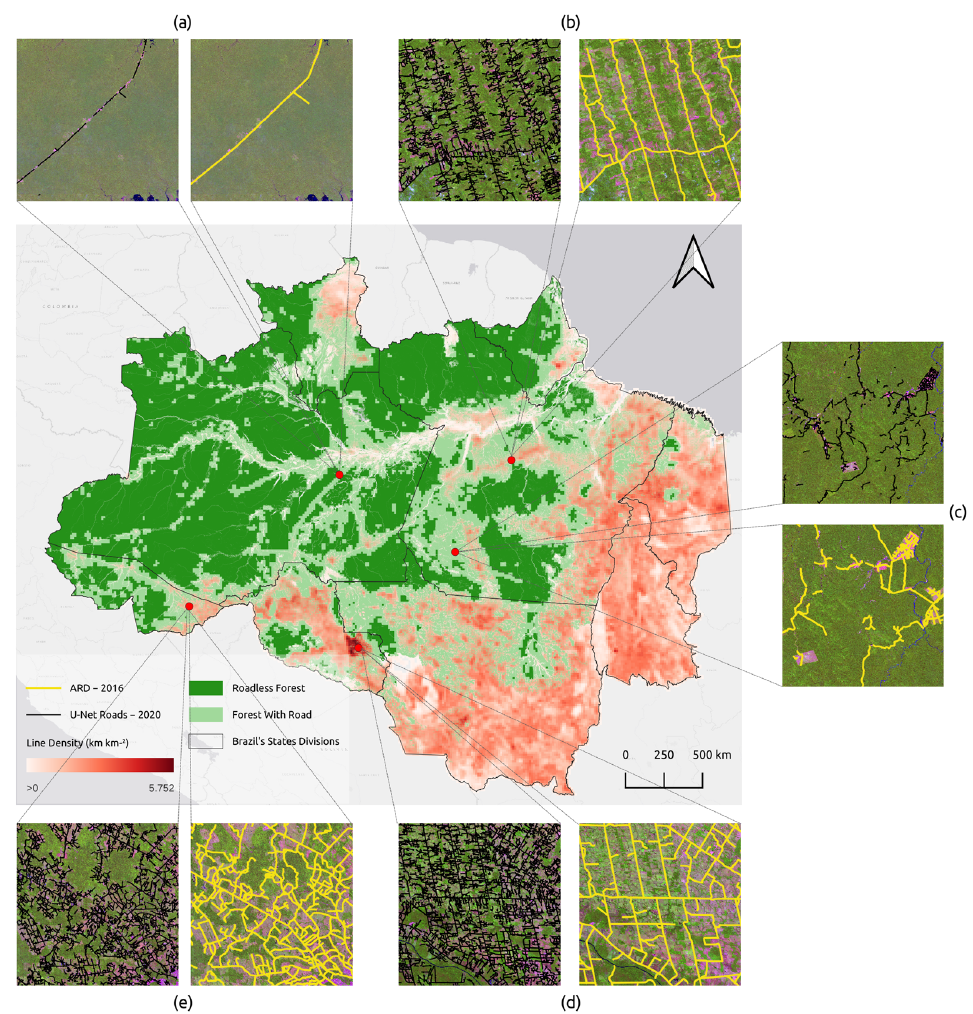
Figure 9. Road density obtained with the U-Net road model. A comparison of the U-Net model (2020) and the Amazon Road Dataset (ARD, 2016) is shown in the image panels: ( a ) the BR-319 highway with unconnected segments by the U-Net road model (black line) and ARD showing the full connected length; ( b ) the fishbone road pattern of the Trans-Amazonia highway main road (BR-230) and perpendicular ones; ( c ) a typical road pattern of selective logging; ( d , e ) a geometric road pattern in agriculture lands.